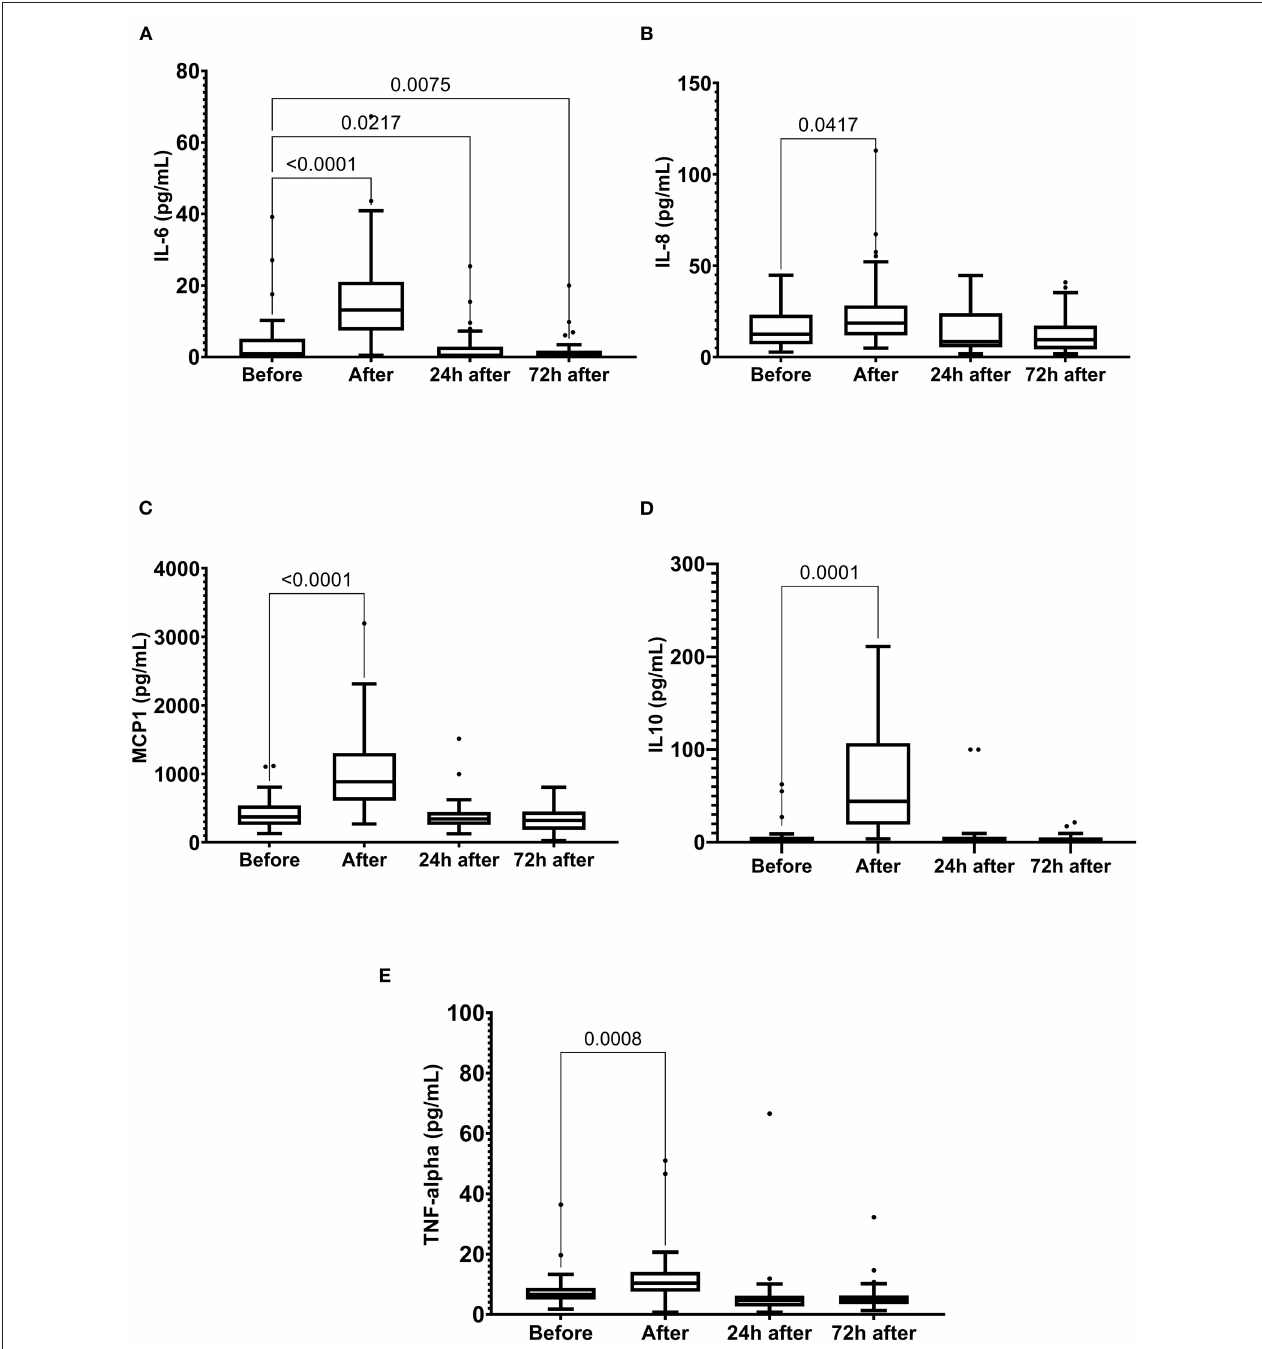
FIGURE 4 | The plasma levels of interleukin (IL)-6 (A) , IL-8 (B) , monocyte chemoattractant protein-1 (MCP1) (C) , IL-10 (D) , and tumor necrosis factor alpha (TNF- α ) (E) immediately after, 24h after, and 72h after the race. The values are presented as minimum, maximum, median, and outliers of 40 runners (IL-6) or 43 runners (MCP1, TNF-alpha, and IL-10) (Box plot, Tukey).